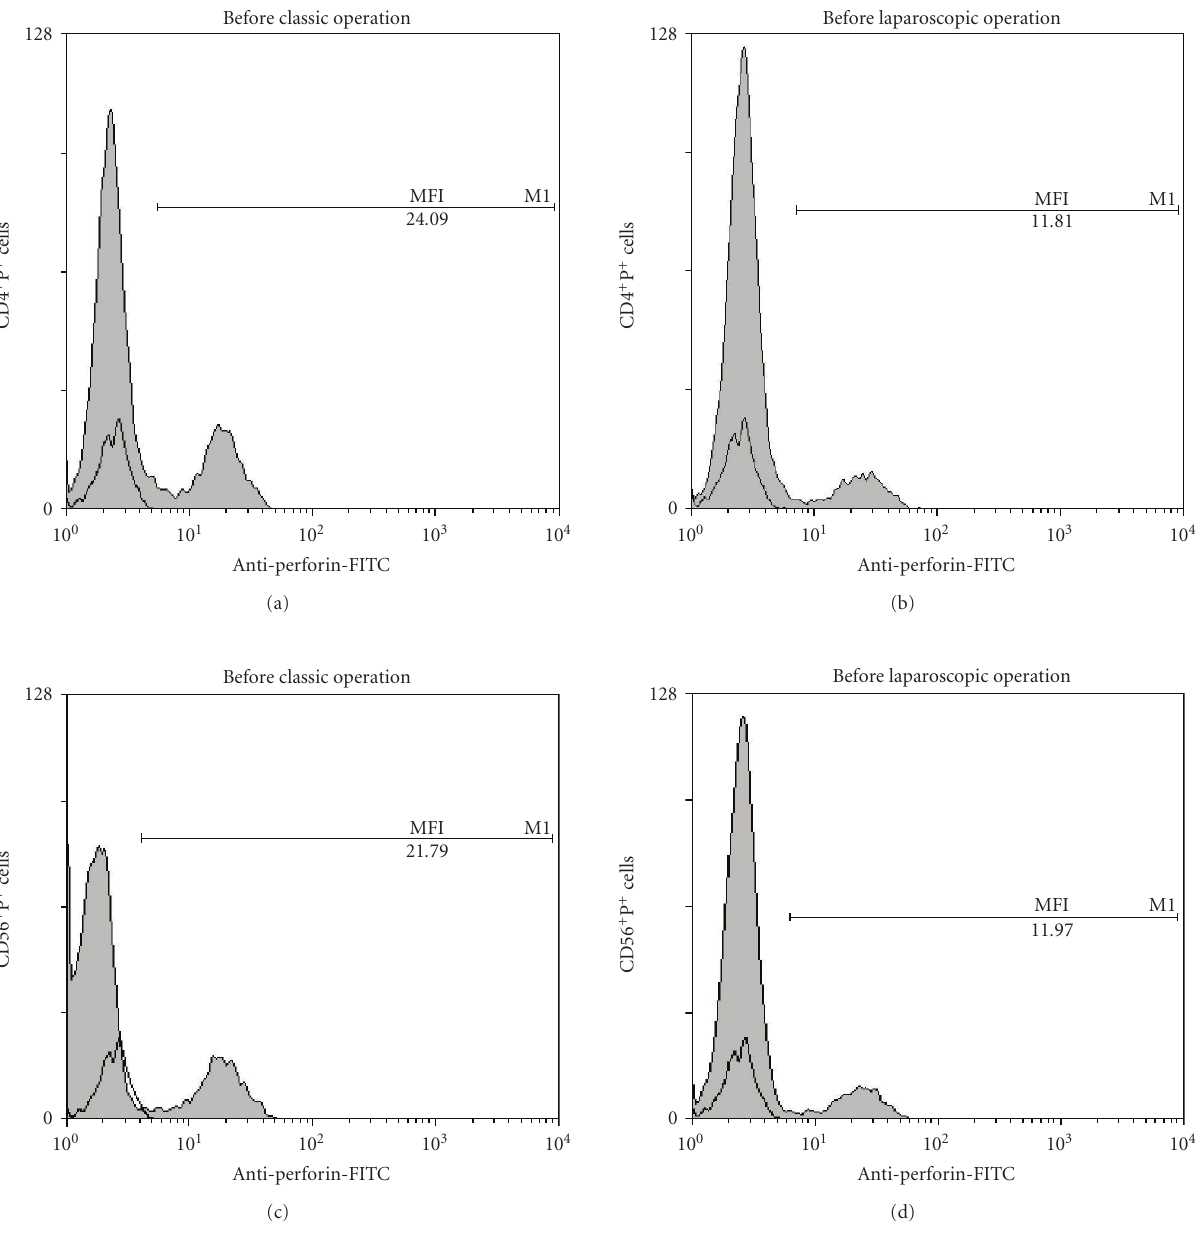
Figure 6: Representative flow cytometric profile of perforin expression on the gated CD4 + and CD56 + PBMNLC before classic and laparoscopic cholecystectomy. The shadow area was perforin expression while the nonshadow area was isotype control. The amount of perforin per cell is indicated by the mean fluorescence